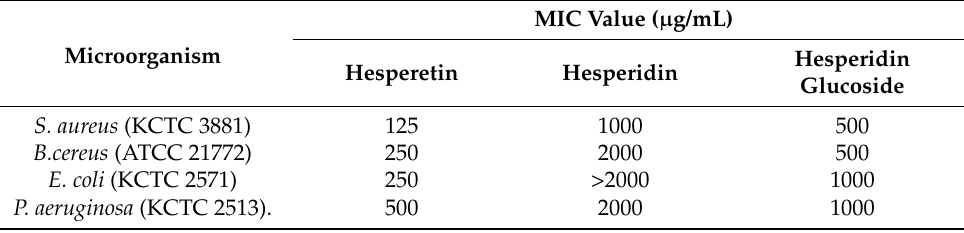
Table 2. Minimal inhibitory concentration (MIC) of hesperetin, hesperidin and hesperidin glucoside.